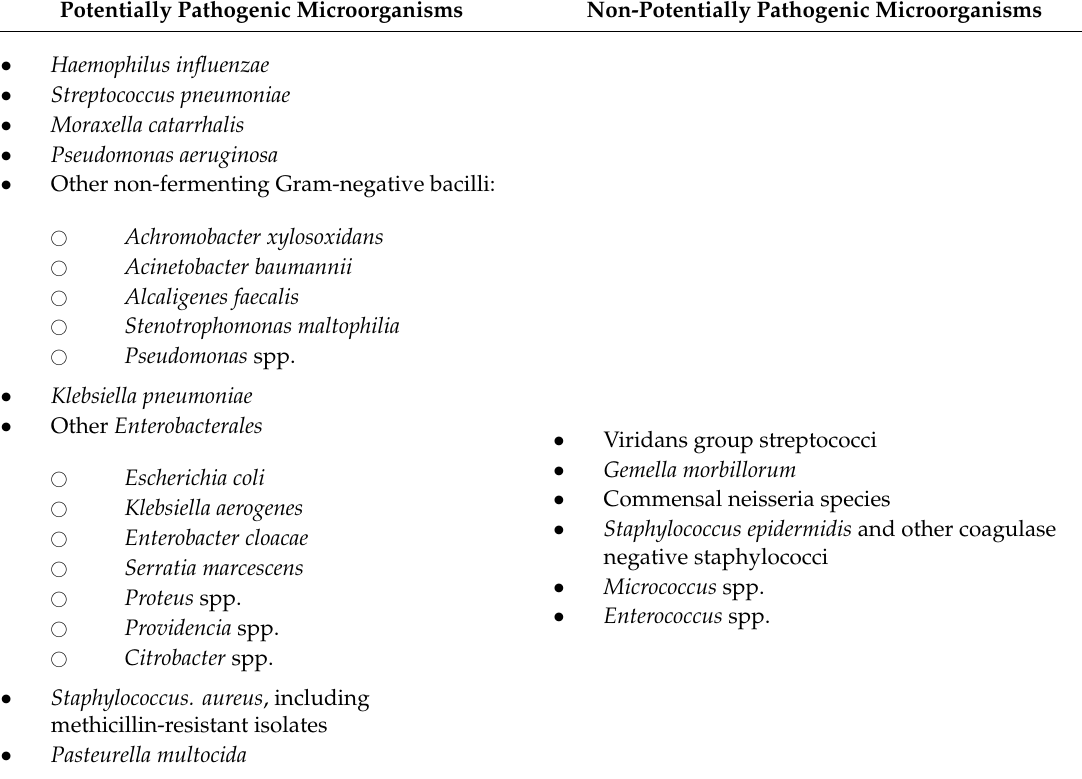
Table 1. List of microorganisms potentially implicated in chronic obstructive pulmonary disease